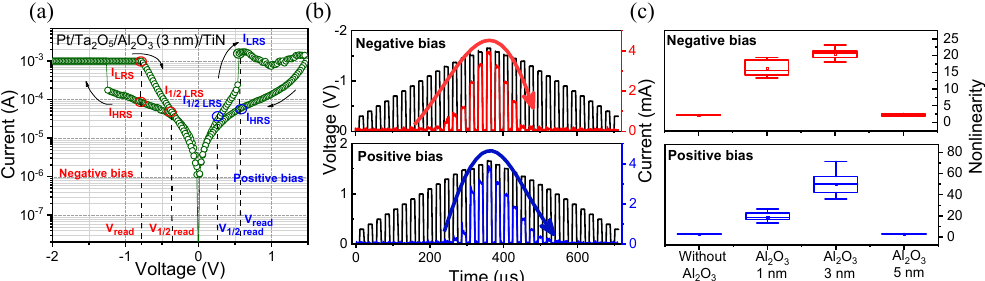
Figure 4. ( a ) Nonlinear I–V curve of Pt/Ta 2 O 5 /Al 2 O 3 (3 nm)/TiN selector-less RRAM device. ( b ) Pulse responses of suppressed characteristics in Pt/Ta 2 O 5 /Al 2 O 3 (3 nm)/TiN device. ( c ) Comparison box plot of nonlinear parameter in both polarities.